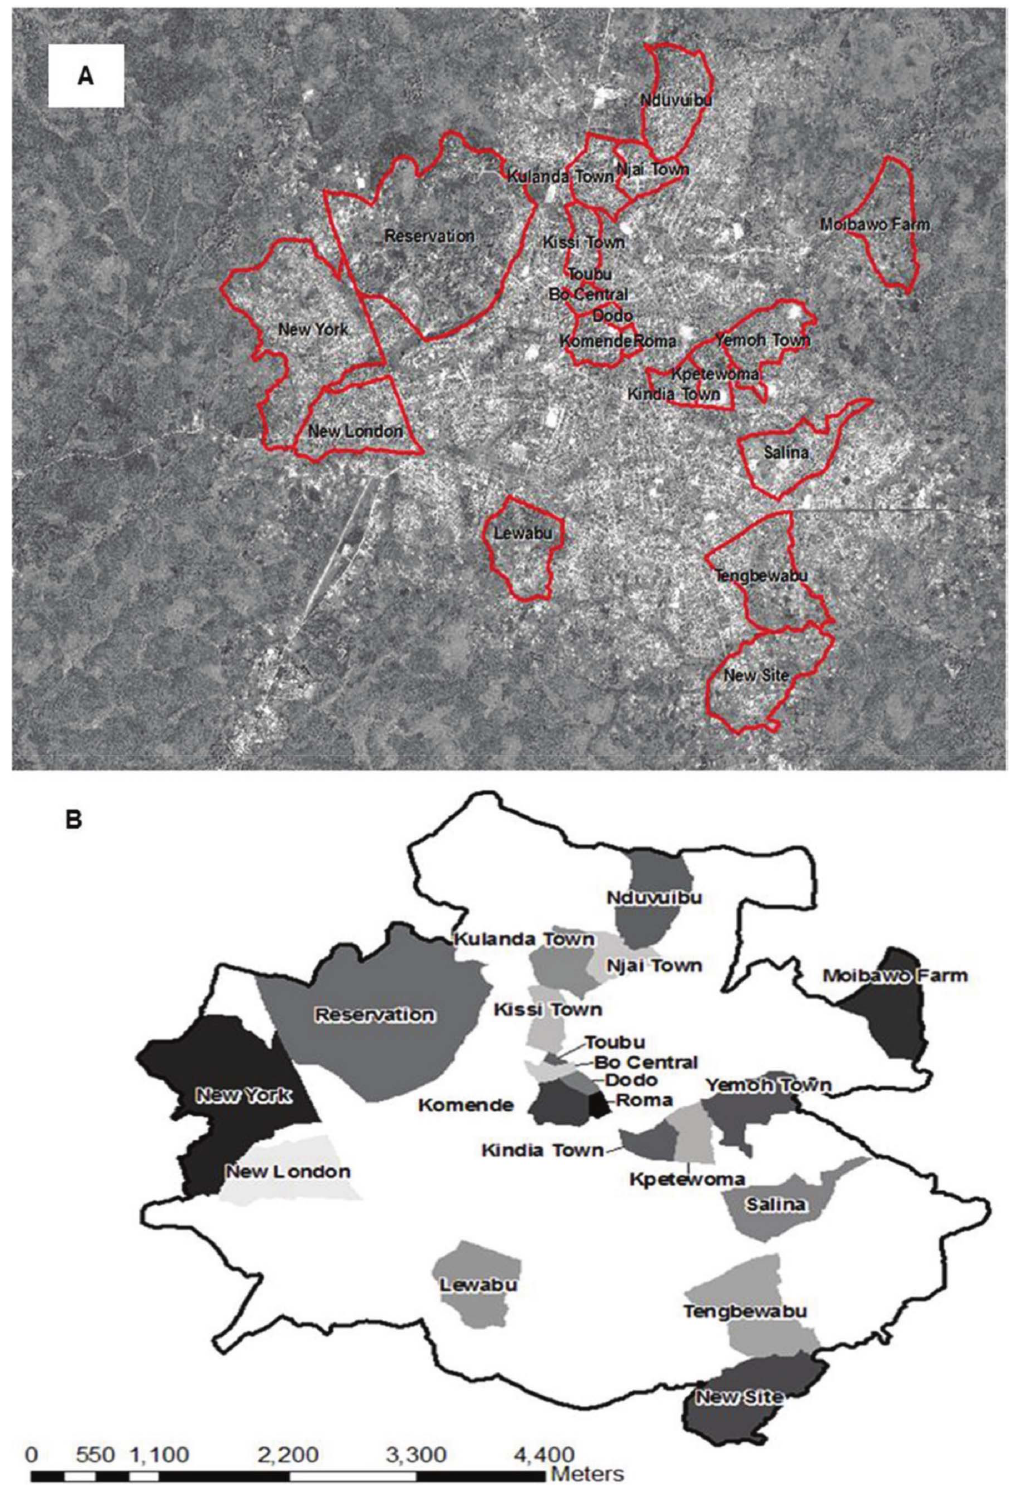
Figure 1. Aerial map of Bo city and municipal sections. (A) Aerial map of Bo, Sierra Leone showing municipal sections (red lines) described in this study and (B) Graphical representation of the same. (Image copyright 2010 DigitalGlobe NextView License. Used with permission.)